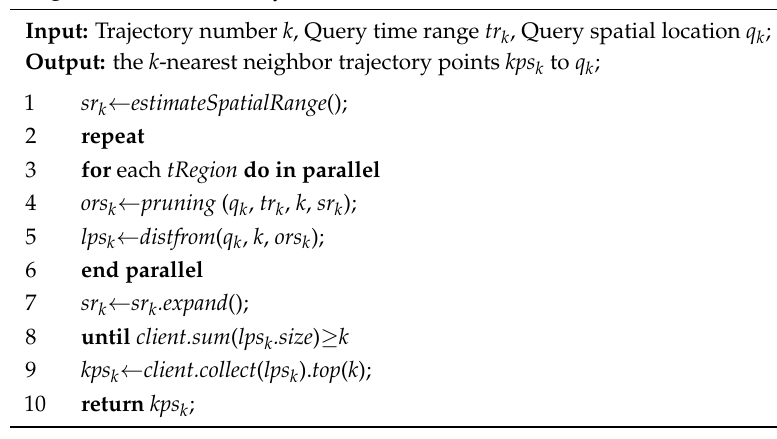
Algorithm 3. k -NN